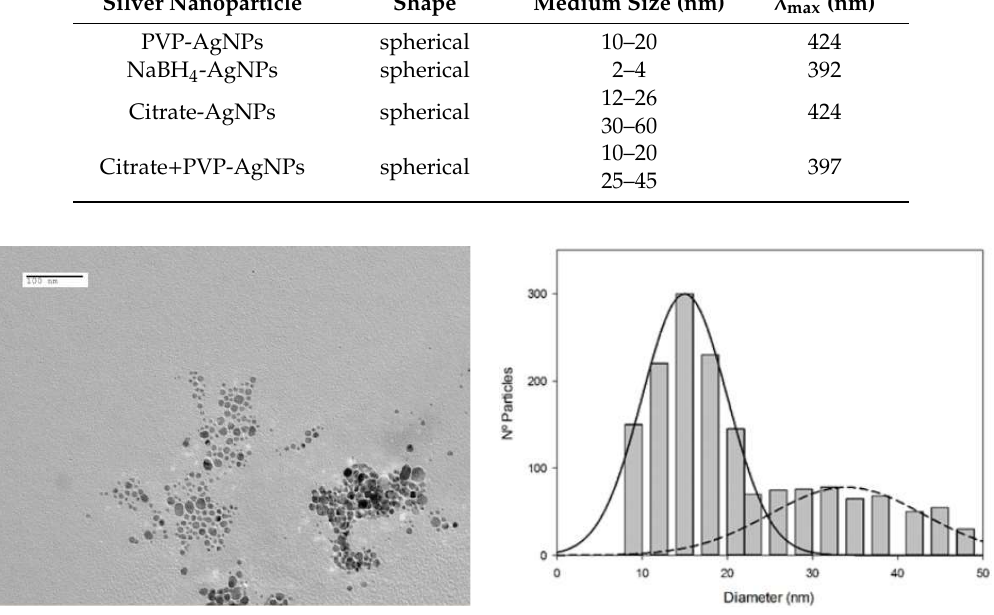
Figure 1. TEM image showing the shape and size of the citrate + PVP-AgNPs and calculated histogram to determine their average size from the TEM images.